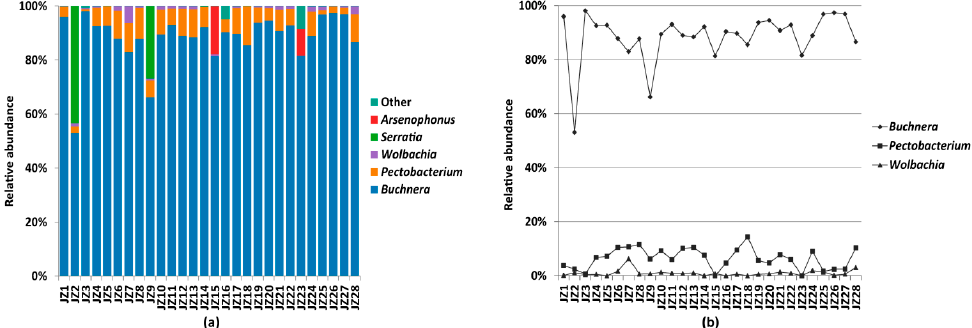
Figure 1. ( a ) Taxonomic composition and relative abundance of symbiotic bacteria at genus level for all Pseudoregma bambucicola samples; ( b ) relative abundance of the three dominant symbionts. In the Pectobacterium phylogenetic tree (Figure 2a), OTU3 and other Pectobacterium species clustered together, while Dickeya and Erwinia formed separate clades, respectively. The genetic distances between OTU3 and all other Pectobacterium sequences ranged from 2.1% to 3.9%, which indicated that the Pectobacterium symbiont in P. bambucicola may repre- sent a new bacterial species of this genus. As the Wolbachia phylogenetic tree (Figure 2b)